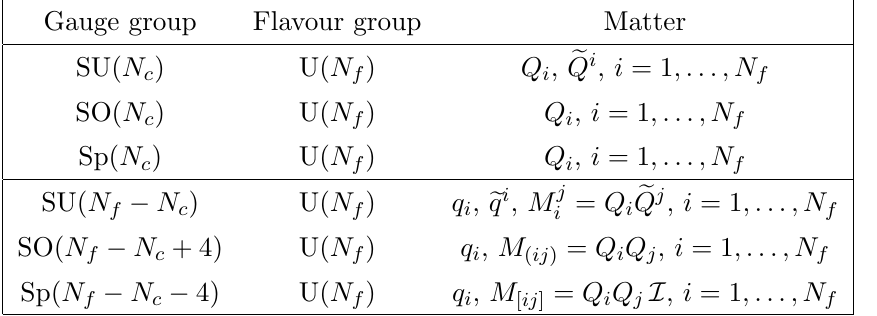
Integrating out the massive quark the gauge group breaks to SO( N tonic contributions are generated for N